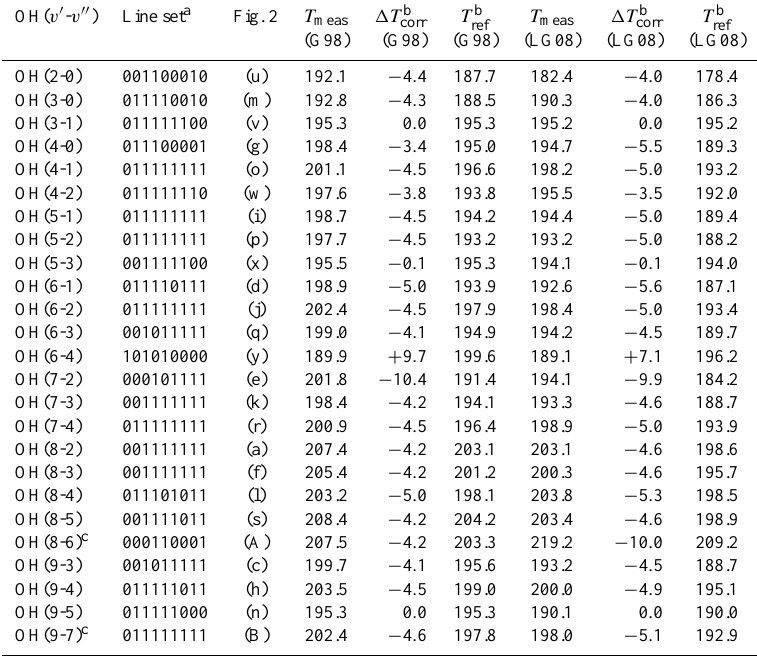
Table 1. Measured and corrected rotational temperatures in K from different OH bands for G98 and LG08 line